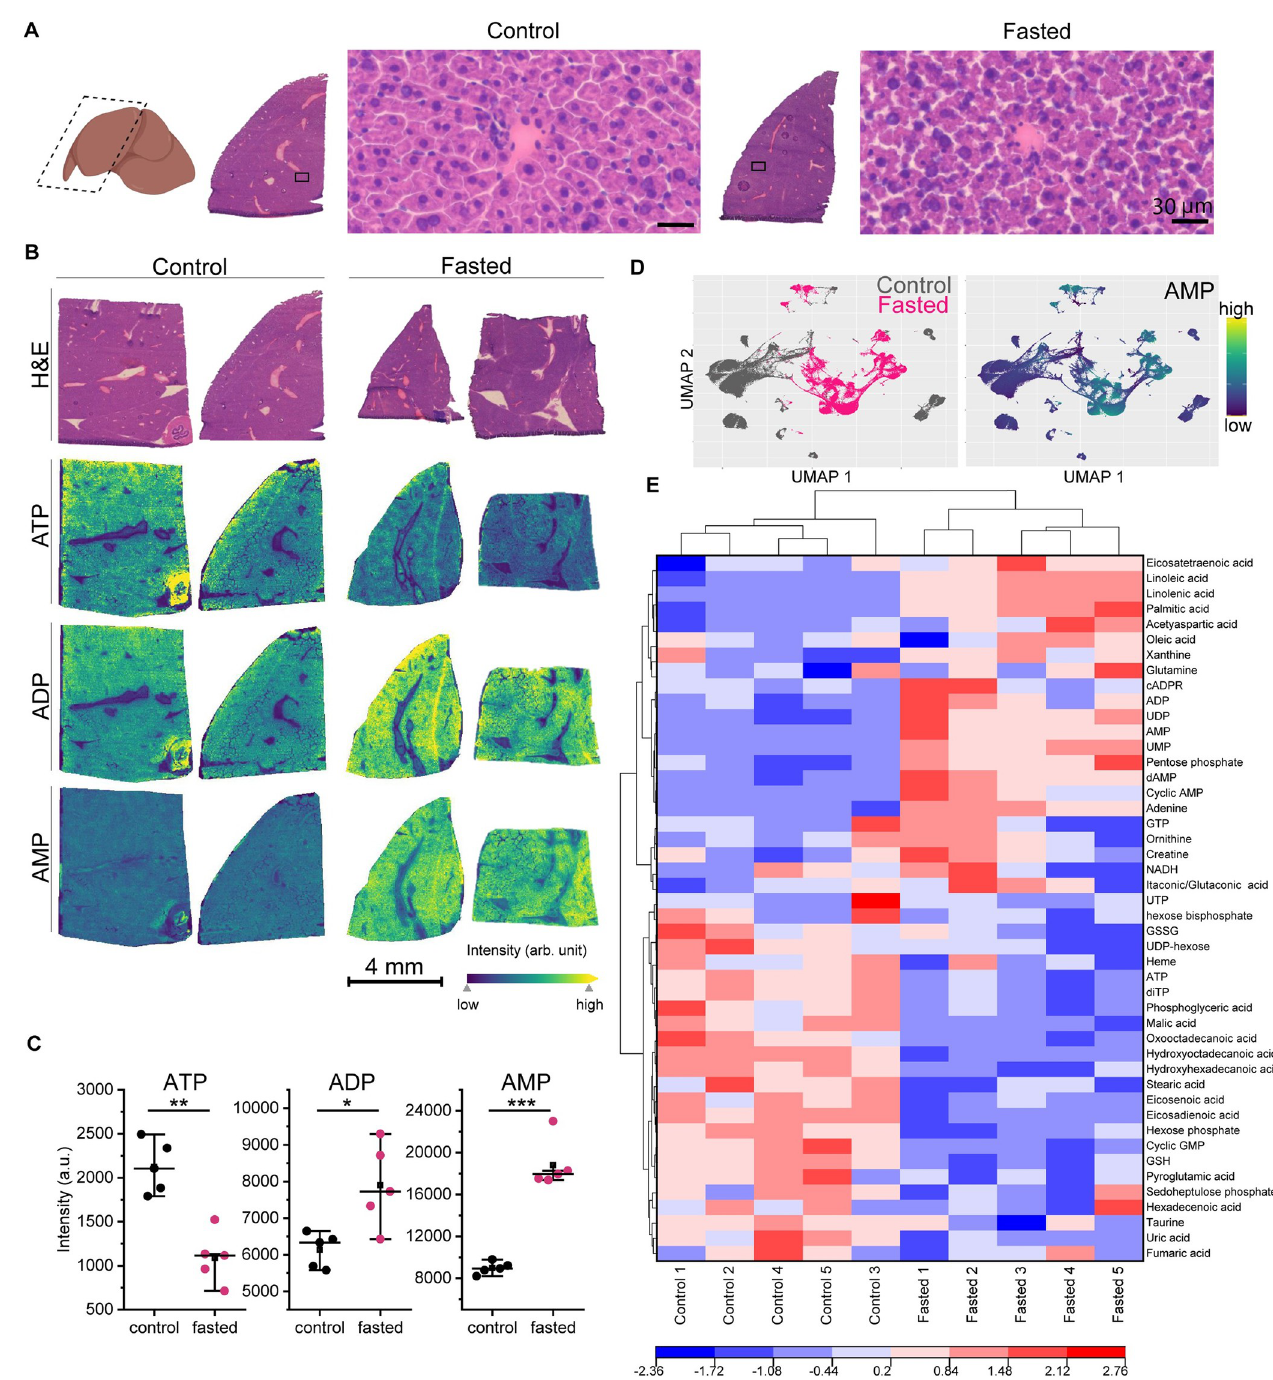
Fig 2. Spatially-resolved metabolic signatures in fed and fasted livers. (A) Histological images (40x magnification) of a representative liver section from ad lib fed mice and those subjected to overnight fasting; n = 5 per group. ( B ) H&E optical and MALDI MSI ion images (30 μ m pixel) of representative serial tissue sections from control and fasted mice. MSI ion images show the relative distribution of ATP, ADP, and AMP. (C) Box-and-whisker plots of ATP, ADP, and AMP levels of the whole liver ROI from control and fasted mice. � P < 0.05, �� P < 0.01, ��� P < 0.001, ���� P < 0.0001 (Student’s t-test) (D) UMAP non-linear dimensionality reduction of MALDI MSI data from liver tissues from ad lib fed mice or those subjected to an overnight fast showed distinct group clustering. The AMP ion intensity plotted onto the UMAP revealed higher abundance in fasted conditions. (E) Heatmap of 46 metabolite levels plotted according to fasted and control states, indicating a metabolic response based on treatment.